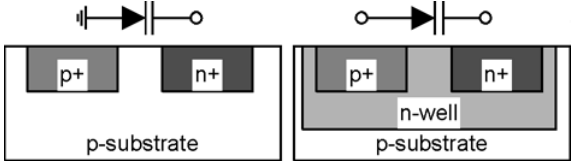
FIGURE 9 CMOS varactor